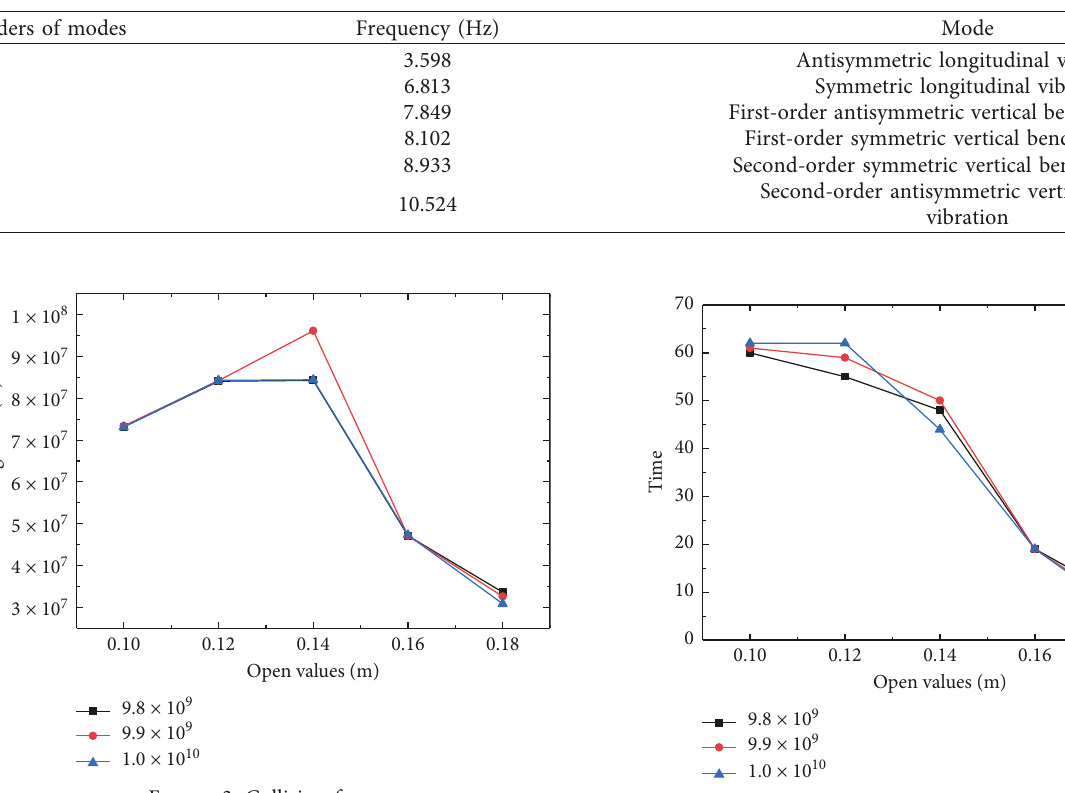
Figure 3: Collision force.